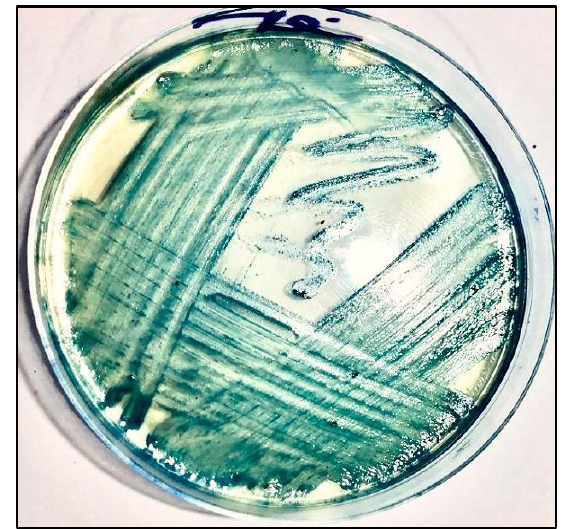
Fig 4. Greenish blue colonies of K. pneumoniae on chrome agar surface after incubation for 24 hru at 37oC under aerobic condition